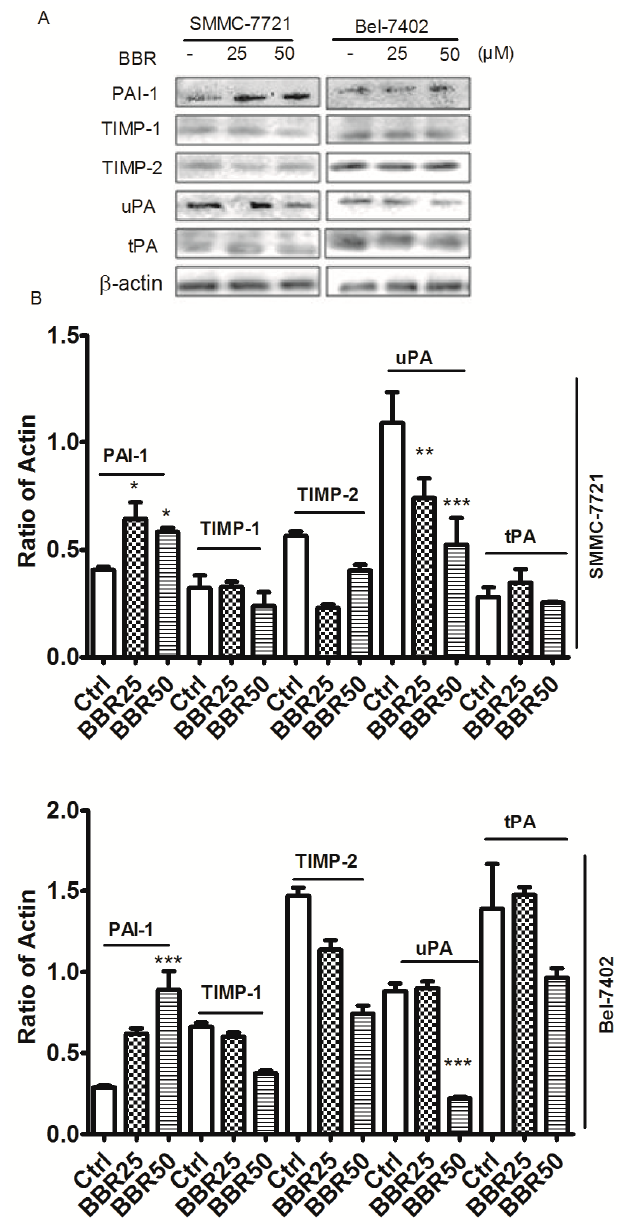
Figure 7. Induction of plasminogen activator inhibitor-1 (PAI-1) and inhibition of urokinase-type plasminogen activator (uPA) in BBR-treated HCC cells by western blot. SMMC-7721 and Bel-7402 cells were treated with BBR for 6 h. Proteins were collected, determined and expression of PAI-1, TIMP-1, TIMP-2, uPA and tissue-type plasminogen activator (tPA) were analyzed by western blot. β -actin was used as internal standard. ( A ) Protein expression was observed by ChemiDoc™ XRS + Molecular Imager; ( B ) Protein expression was calculated by ImageJ 1.38x software. * p < 0.05 ( vs. the control group); ** p < 0.01 ( vs. the control group); *** p < 0.001 ( vs. the control group).